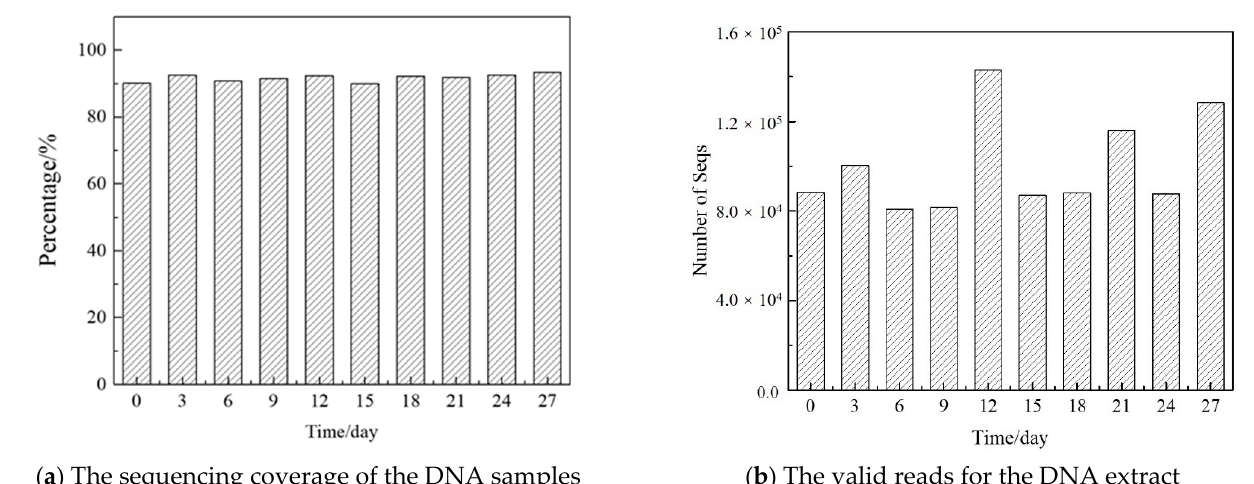
( a ) The sequencing coverage of the DNA samples ( b ) The valid reads for the DNA extract Figure A3. Data of sequencing coverage and sequencing reads. Figure A3. Data of sequencing coverage and sequencing reads. Table A4. The statistics for cluster and distribution of the DNA reads. Table A4. The statistics for cluster and distribution of the DNA